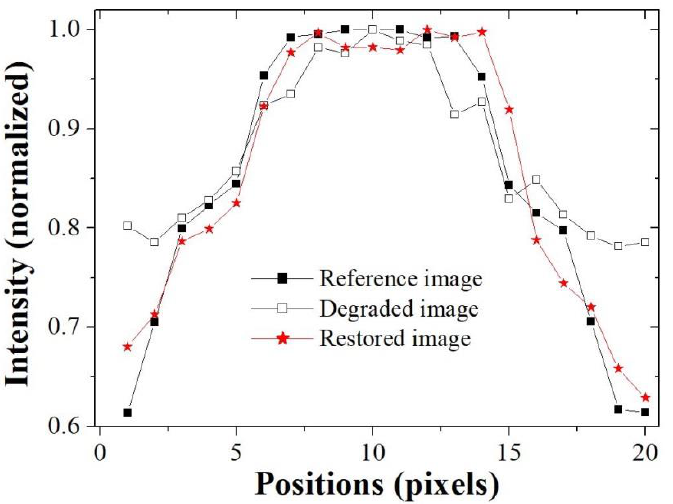
Figure 5. Resultant profiles measured along the broken red line in Figure 3 with box C . The intensities of each profile are normalized to the corresponding maximum.